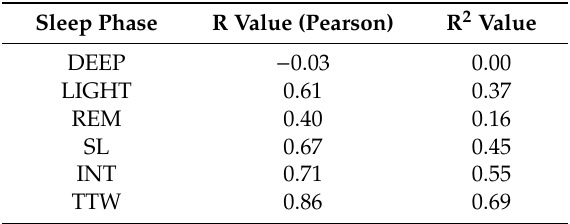
Table 1. R and R 2 values computed for each phase: DEEP, LIGHT, REM, and AWAKE (SL, INT, and